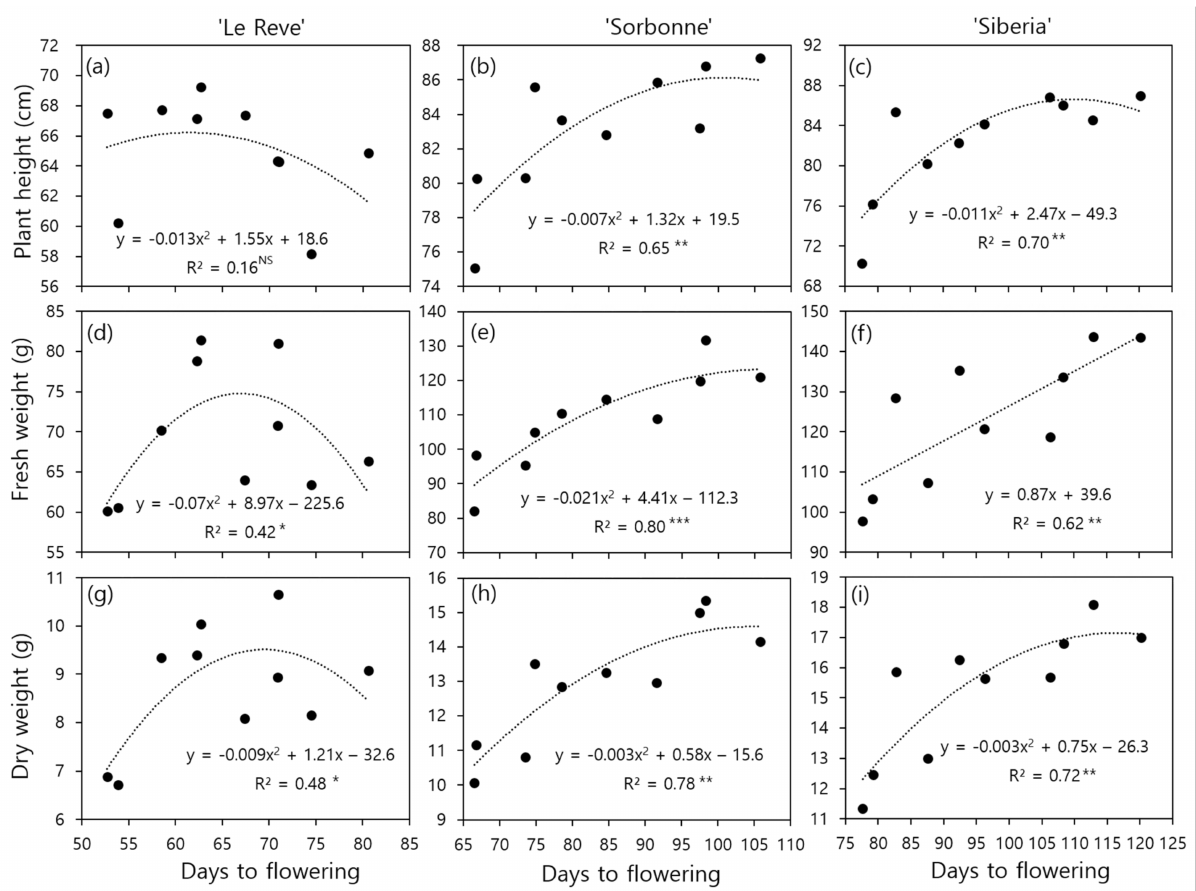
Figure 5. Correlation between days to flowering and plant height ( a – c ), fresh ( d – f ) and dry ( g – i ) weights of cut flowers as influenced by bulb storage period at 0 ◦ C in Lilium Oriental Hybrids ‘Le Reve’ ( a , d ), ‘Sorbonne’ ( b , e ), and ‘Siberia’ ( c , f ). NS, *, **, *** Non-significant or significant at p < 0.05, 0.01, or 0.001,